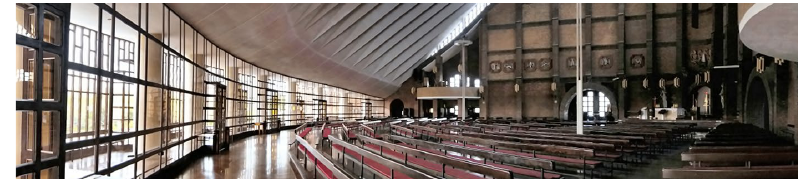
Figure 2. Panorama of the church showing the glazed entrance part in